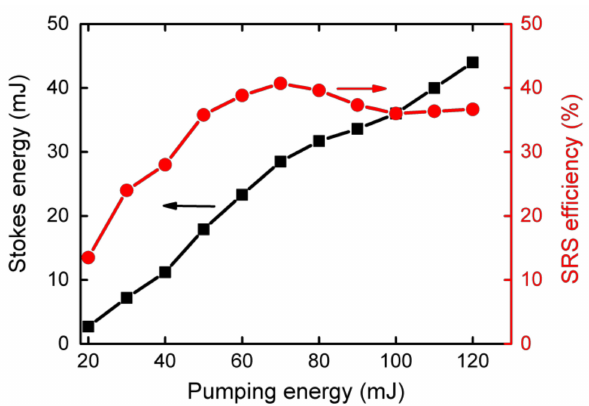
Figure 3. Output Stokes energy (black line) and optical conversion e ffi ciency (red line) of Stokes lasers in comparison to the energy of the 1064 nm pumping